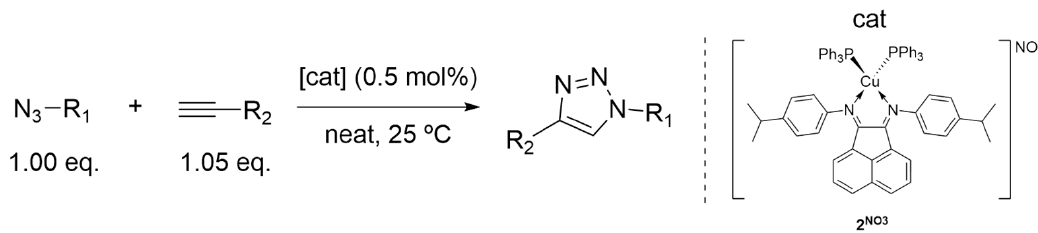
Scheme 4. Reaction conditions of catalysis scope using the chosen catalyst 2 NO 3